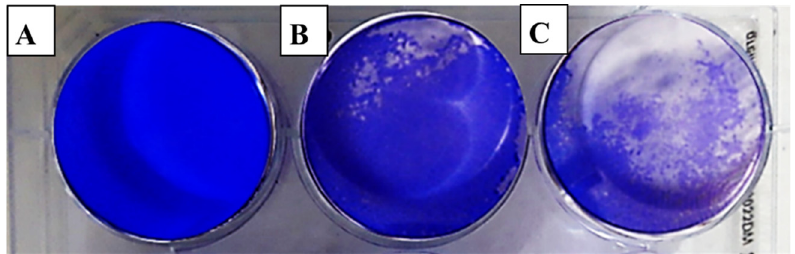
Figure 3. Effect of clove essential oil on plaque formation by the herpes simplex virus (HSV-1) in cell culture using the plaque reduction assay: ( A ) Vero cells (control); ( B ) Vero cells infected with HSV-1 and treated with oil; ( C ) Vero cells infected with HSV-1 (infection control).